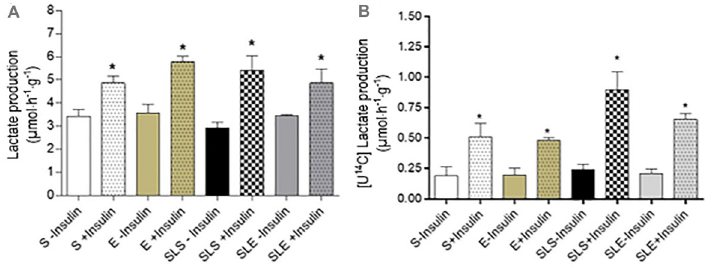
Figure 6. Total lactate ( A ) and radiochemical lactate ( B ) production from glucose by epididymal isolated incubated fat tissues obtained from sedentary (S), exercise (E), small-litter sedentary (SLS), and small-litter exercise (SLE) rats. Epididymal fat tissue was incubated in Krebs-Ringer bicarbonate buffer, containing 5.6 mM glucose, 0.1 uCi/mL D-[U 14 C] glucose, for 1 h in the absence or presence of 10 mU/mL insulin. Data are reported as means ± SE (n=8). *P o 0.05 vs non-stimulated (ANOVA).